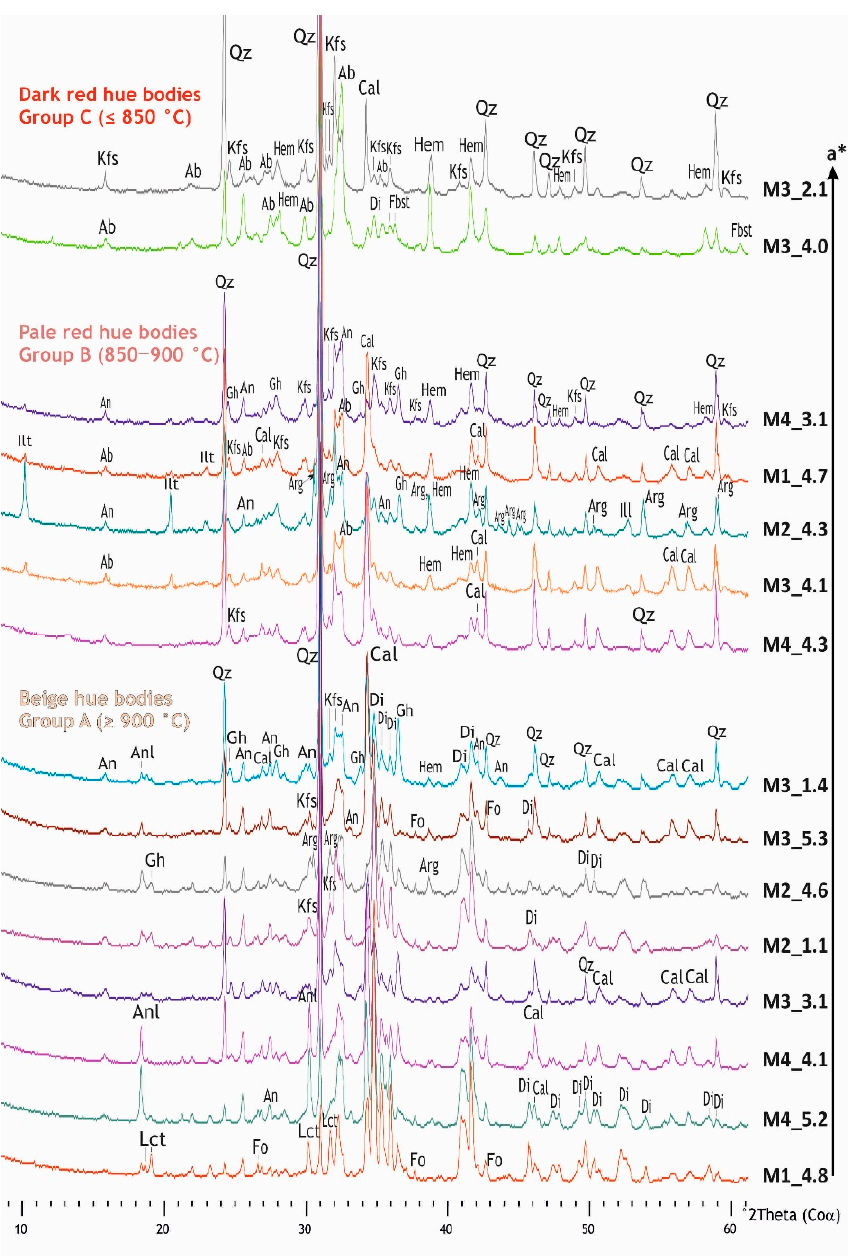
Figure 6. PXRD patterns of the beige, pale red and dark red hue ceramic bodies, according to the increasing of the red component (a* chromatic coordinate). Mineral abbreviations: quartz (Qz), k-feldspars (Kfs), illite (Ilt), albite (Ab), anorthite (An), diopside (Di), gehlenite (Gh), forsterite (Fo), hematite (Hem), ferrobustamite (Fbst), calcite (Cal), aragonite (Arg), analcime (Anl) and leucite (Lct), after Whitney and Evans [75].